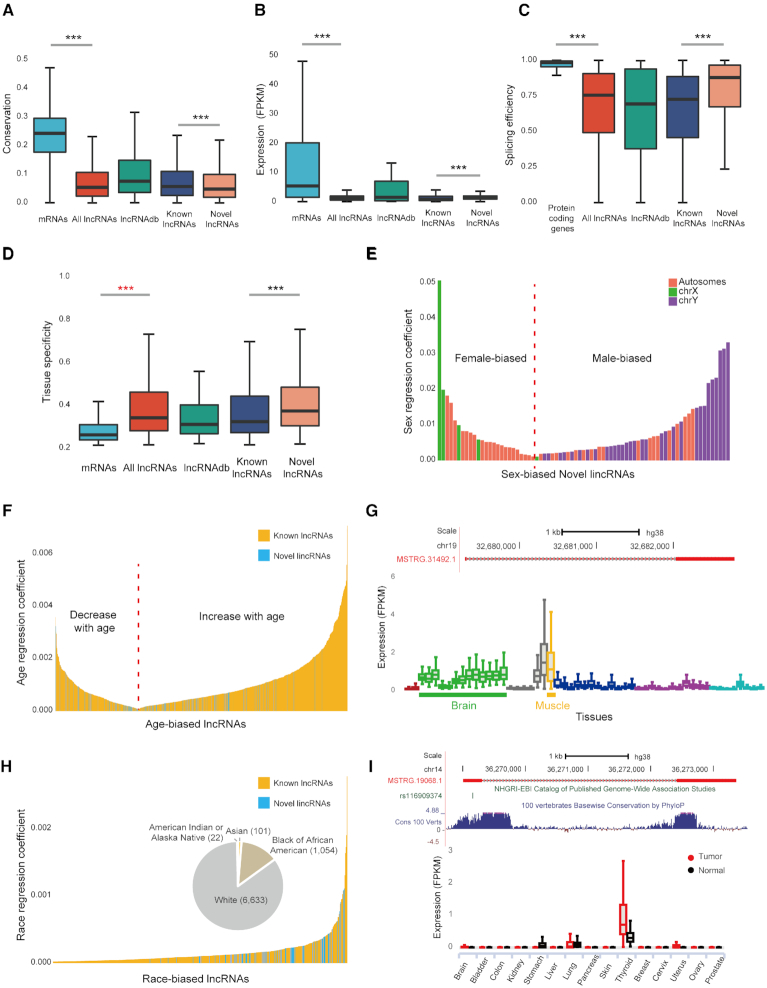
Characterization of the RefLnc assembly. (A) The conservation of lncRNAs is lower than that of mRNAs. (B) The expression levels of lncRNAs are lower than that of mRNAs, with 4.8-fold and 13.3-fold lower for median and mean expression levels, respectively. (C) lncRNAs have lower splicing efficiency than protein-coding genes. (D) lncRNAs are expressed in a much more tissue-specific manner than mRNAs. P-values are calculated using the Wilcoxon rank sum test. ‘***’: P-value < 0.001. (E) Sex-biased novel lincRNAs that are differentially expressed between males and females (FDR < 0.05). The transcripts on the left side of the red dotted line represent novel lincRNAs up-regulated in the female, while the right side represents novel lincRNAs up-regulated in the male. (F) Novel lincRNAs and known lncRNAs correlated with age (FDR < 0.001). The left side of the red dotted line indicates that the expression of the lncRNAs decreases with increasing age, while the right side indicates that the expression of the lncRNAs increases with the increasing age. (G) The genomic view and expression patterns in normal samples of the age-associated novel lincRNA MSTRG.31492.1. (H) Novel lincRNAs and known lncRNAs that are differentially expressed across different races (FDR < 0.05). The pie chart shows the population of the samples. (I) The genomic view and differential expression patterns between tumors and normal tissues of the novel lincRNA MSTRG.19068.1, which overlaps a thyroid cancer risk-associated SNP.